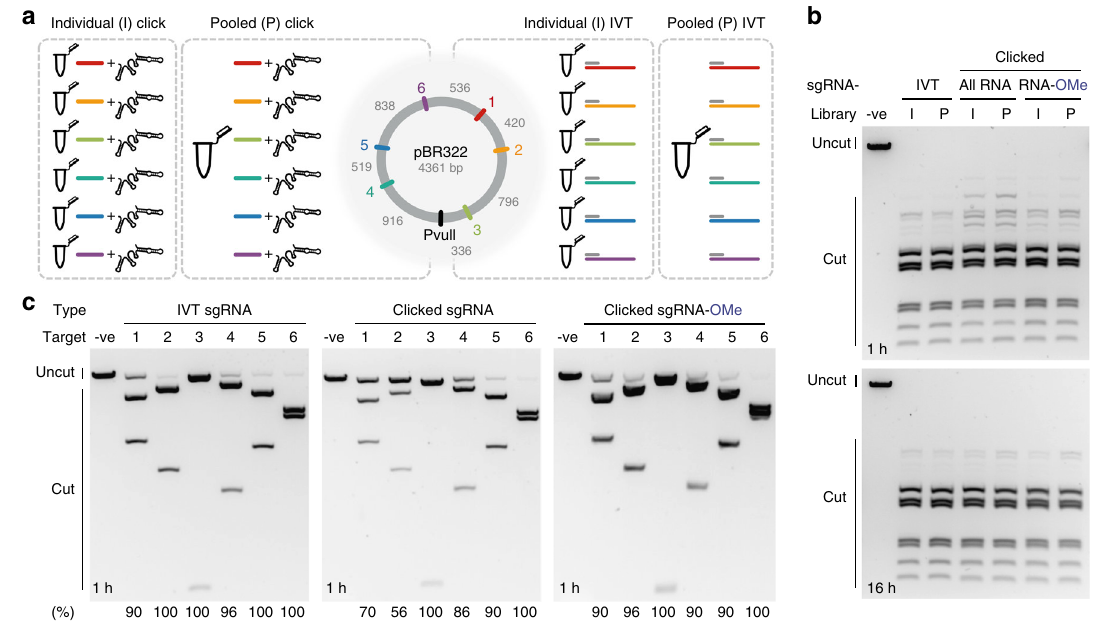
Fig. 3 Clicked 20 – 79 sgRNA library activity in vitro. a illustrates preparation of sgRNAs by click ligation or in vitro transcription (IVT) for cutting a PvuII- linearised plasmid (colour-coded target sites). Each sgRNA was prepared individually (I) or in a pooled (P) one-pot reaction. Full sequences can be found in Supplementary Data 1. b shows the activity of the combined individually prepared sgRNAs (I) and pooled sgRNAs (P) in Cas9-mediated DNA cleavage at 1 and 16 h time points. Comparable DNA cleavage indicates minimal bias in library preparation. c shows the performance of individually prepared sgRNAs in DNA cleavage after a short time period (1 h). Clicked sgRNAs show comparable or lower DNA cleavage to IVT sgRNA but upon the introduction of 2 ′ -OMe modi fi cations activity is restored to IVT sgRNA levels. Cleavage values (under the gel) were quanti fi ed using an Agilent Bioanalyzer (Supplementary Fig. 7) where cleavage (%) = f cut / f total ×100 and f stands for fraction. Source Data are provided as a Source Data fi